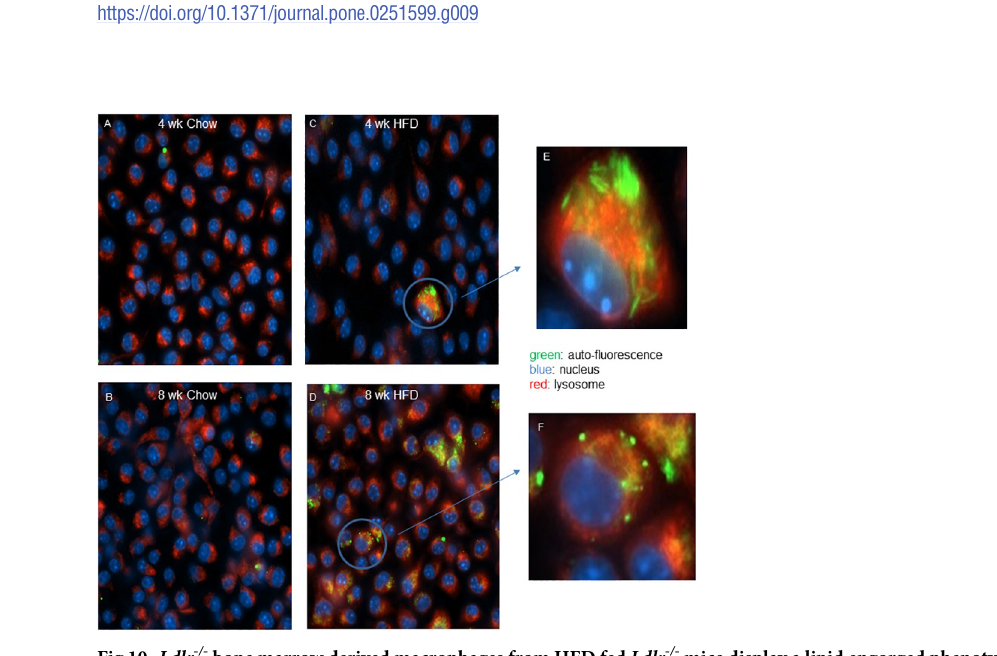
Fig 10. Ldlr -/- bone marrow derived macrophages from HFD fed Ldlr -/- mice display a lipid engorged phenotype. Ldlr -/- mice were fed a chow or a HFD for 4 (panel A & C) or 8 weeks (B & D) and the bone marrow derived macrophages cultured for 5 days were imaged for auto-fluorescence (green) and counterstained for nuclei (blue) and lysosome (red). Circled area in C & D are shown in more detail in E and F, respectively.